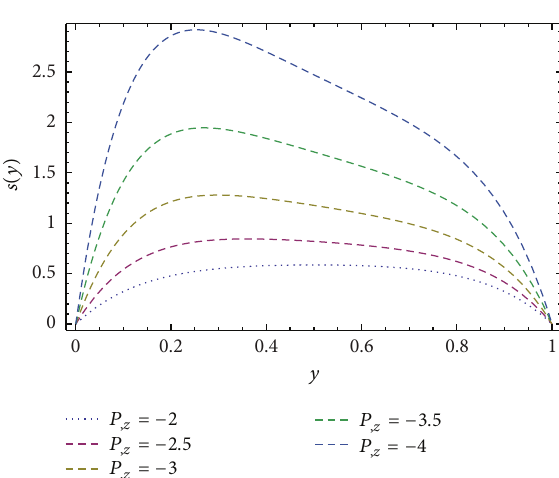
Figure 9: Profile of the nondimensional velocity 𝑠(𝑦) for different ̃ 𝛽 = 0.3 , 𝑃 ,𝑧 = −2.0 , and 𝜙 = 45 ∘ . values of 𝑃 ,𝑥 , keeping